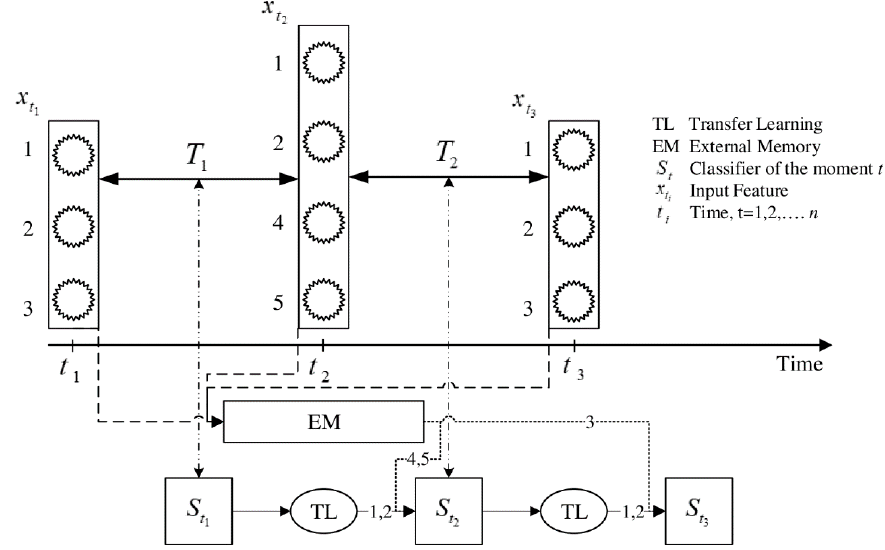
Figure 1. Evolution of classifiers over time based on feature changes.